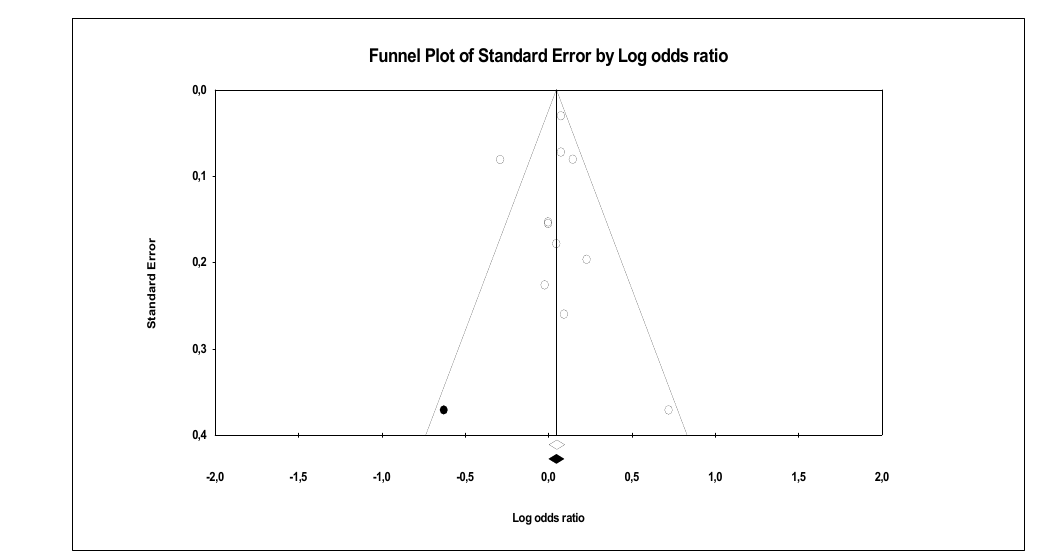
Figure 10. Funnel plots of observational studies of the association of PHxS exposure with CVDs and their risk factors. The publication bias is adjusted by imputing the missing studies based on the asymmetry of the funnel plot. (●) Plot Imputed and ( ○ ) Plot observed studies. Egger’s linear regression test (Intercept 0.02, t = 0.03, p = 0.10). Adjusted values ‘Trim and Fill’ test 0.98 (0.89, 1.09). Int. J. Environ. Res. Public Health 2021 , 18 ,